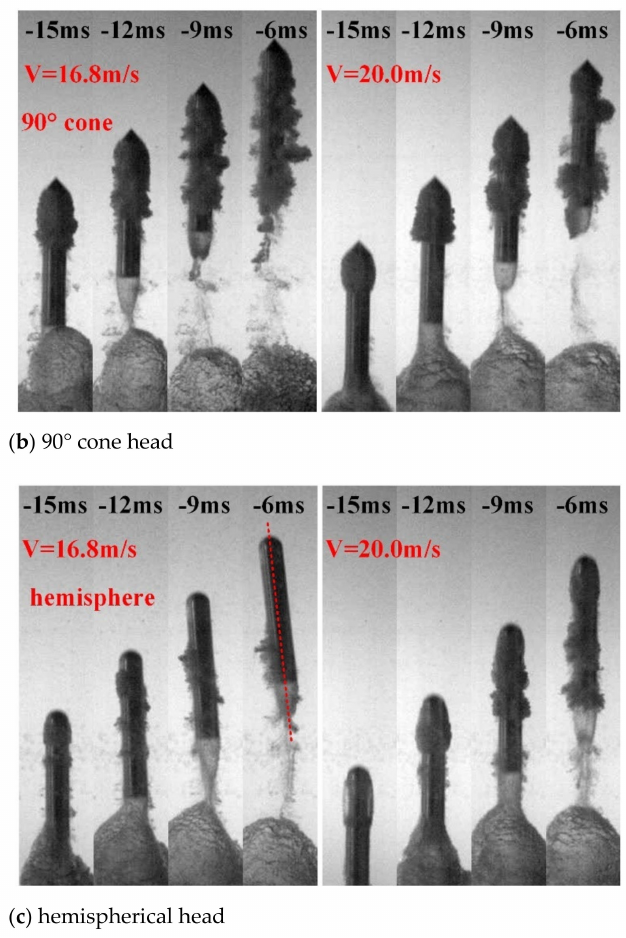
Figure 8. Unsteady cavitation evolution process of three head-shaped projectiles at 16.8 m/s and